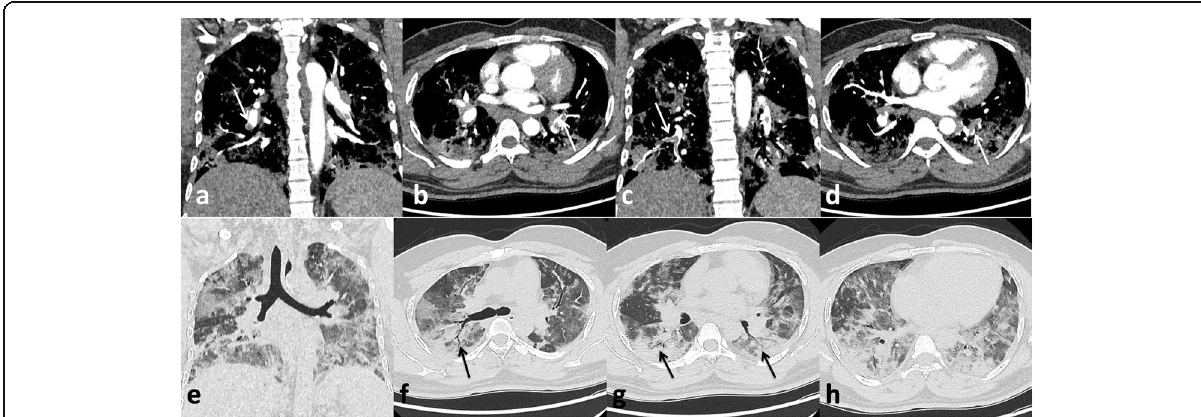
Fig. 4 Male patient, 33 years old. Pulmonary embolism at segmental pulmonary arteries (white arrows a, b, c, d ), bilateral consolidation patches of COVID-19 infection with air bronchogram (black arrows f and g )